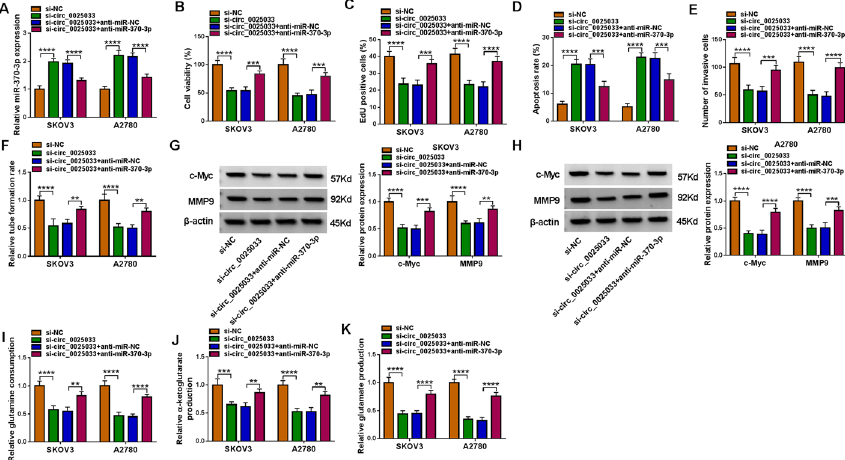
Fig. 4 circ_0025033 silencing inhibited ovarian cancer cell malignant behaviors via targeting hsa_miR-370-3p. A – K SKOV3 and A2780 cells were transfected with si-NC, si-circ_0025033, si-circ_0025033 anti-miR-NC, or si-circ_0025033 anti-hsa_miR-370-3p. A Expression of hsa_miR-370-3p + + measured by qRT-PCR. B and C Cell proliferation detected using CCK-8 assay and EdU assay. D – F Apoptosis, invasion, and angiogenesis ability assessed using flow cytometry, transwell, and tube formation assays. G and H Western blot analysis of c-Myc and MMP9. I – K Glutamine assay kit, α-ketoglutarate assay kit, and glutamate assay kit were utilized to detect glutamine consumption, α-ketoglutarate production, and glutamate production, respectively. ** P < 0.01, *** P < 0.001, **** P <